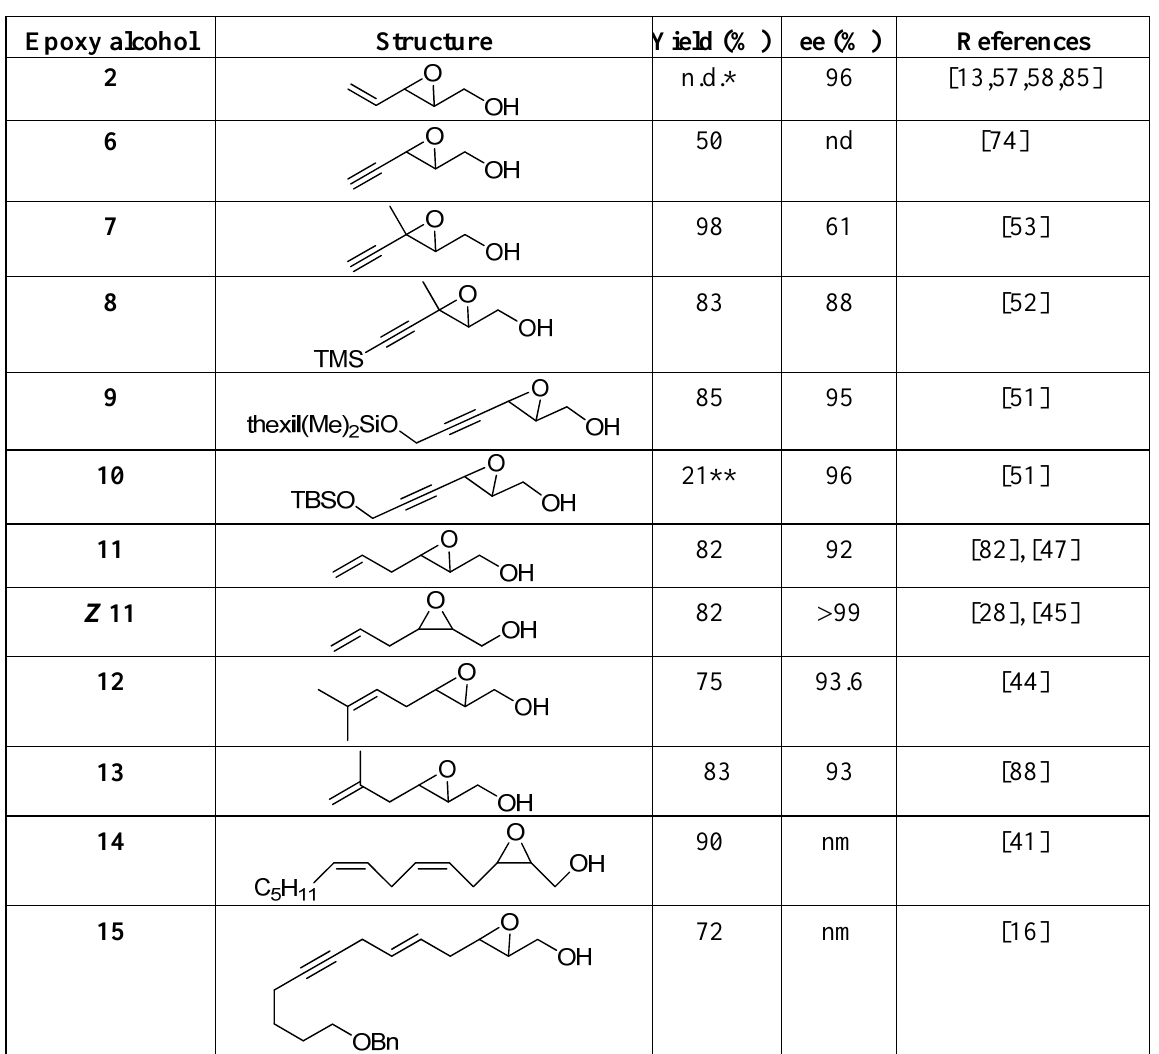
Table 1. Unsaturated epoxides prepared by Sharpless asymmetric